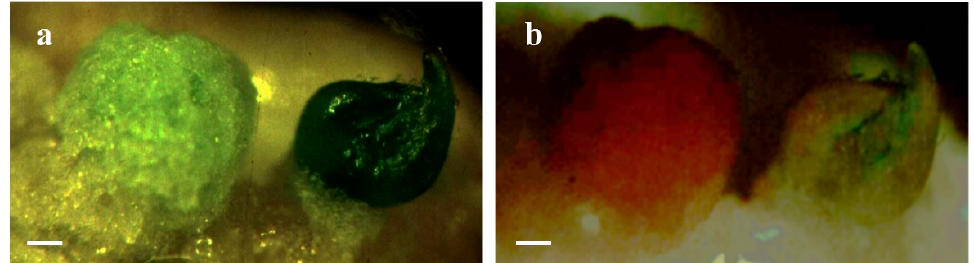
Figure 1. Callus and shoot in Troyer citrange internode observed under a stereomicroscope with white light ( a ) and 480 nm-excited blue light ( b ); in the latter case, it is possible to discriminate the ‘escape’ callus (red) and the fluorescent transgenic shoot (green). Bar = 1 mm.